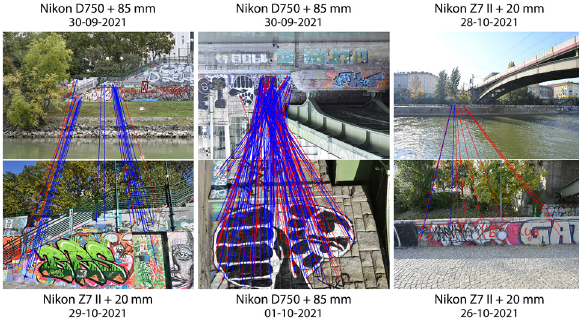
Figure 4 . Metashape established valid image matches (blue lines) between photographs acquired from opposite sides of the Donaukanal. Red lines represent rejected tie points.